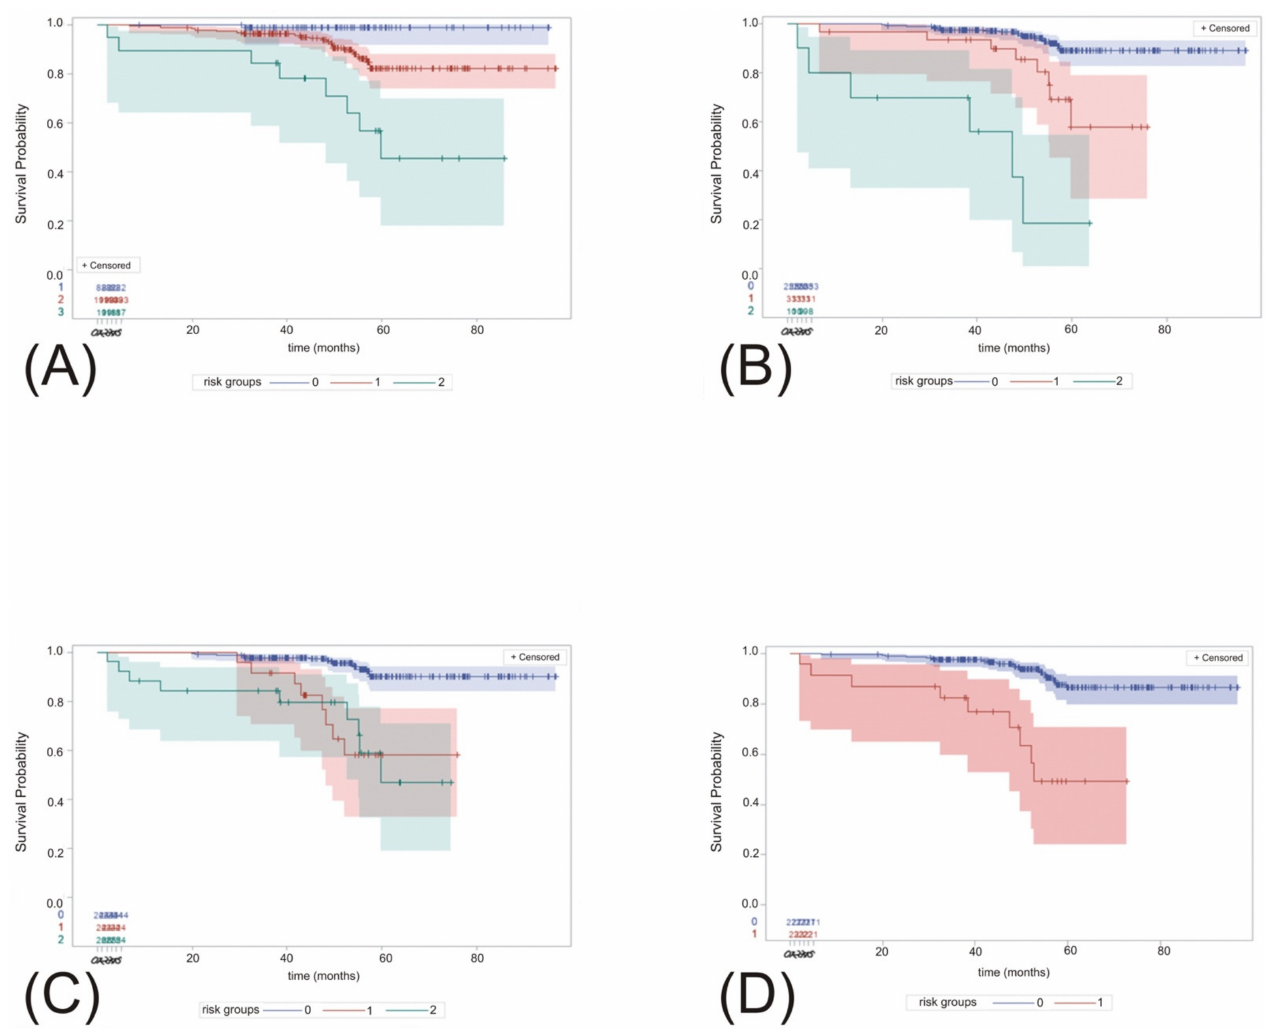
Figure 2. Kaplan–Meier curves representing overall survival according to the risk stratification as determined by our classification ( A ), and Leibovich ( B ), VENUSS ( C ) and GRANT ( D ) models. p -Values < 0.0001 were reached in all the respective models between the risk groups. Respective risk groups (0–2) were presented in different colors ( A – D